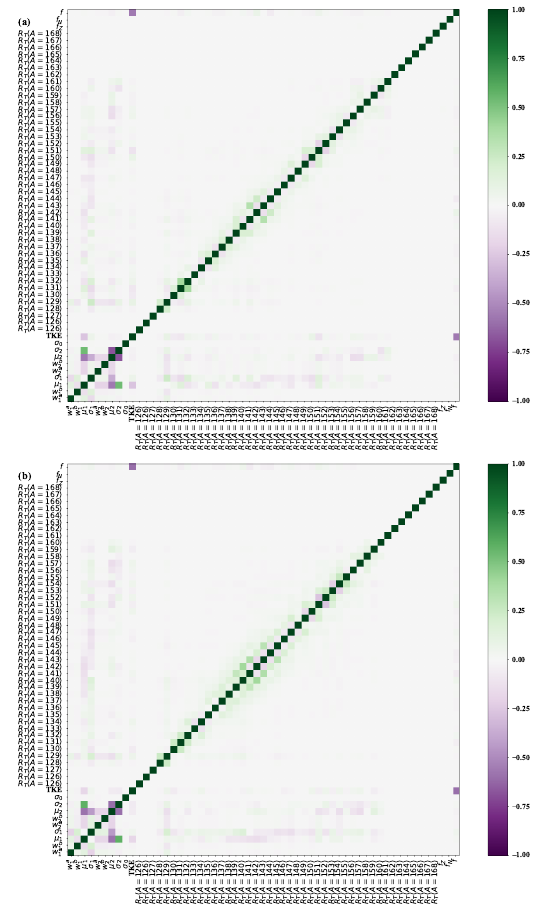
Figure 2. Parameter correlation matrix for (a) the fit to experi- mental data from EXFOR and (b) the fit to evaluated data from ENDF / B-VIII.0 for 252 Cf(sf).